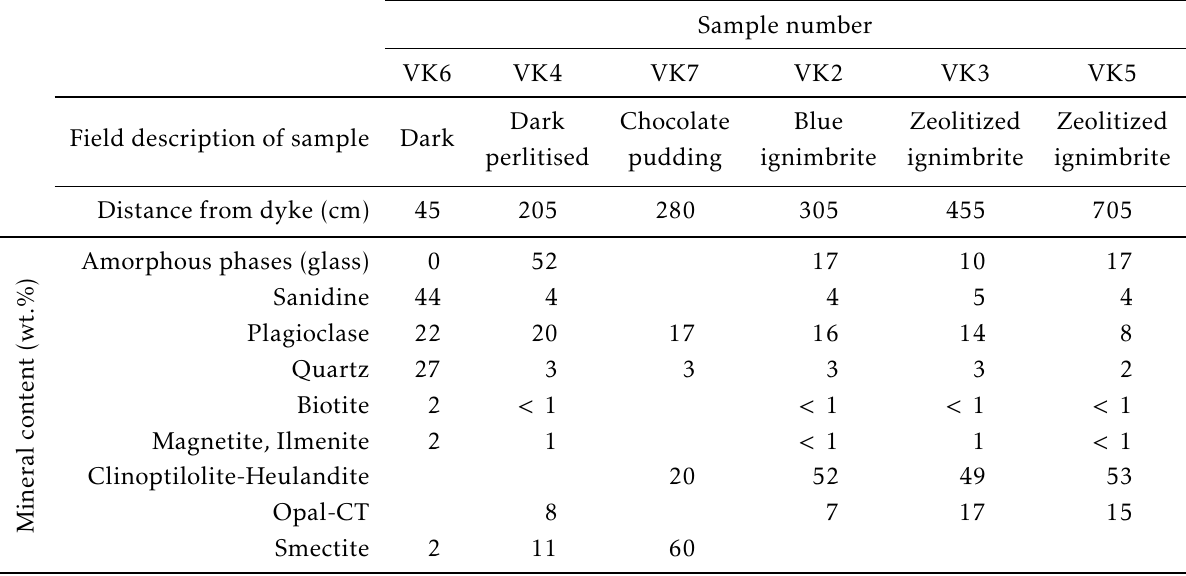
Table 2: Quantitative phase analysis for the rocks collected as a function of distance from the dyke (VK6, VK4, VK7, VK2, VK3, and VK5; see Figure 2 derived from X-ray powder diffraction analyses.